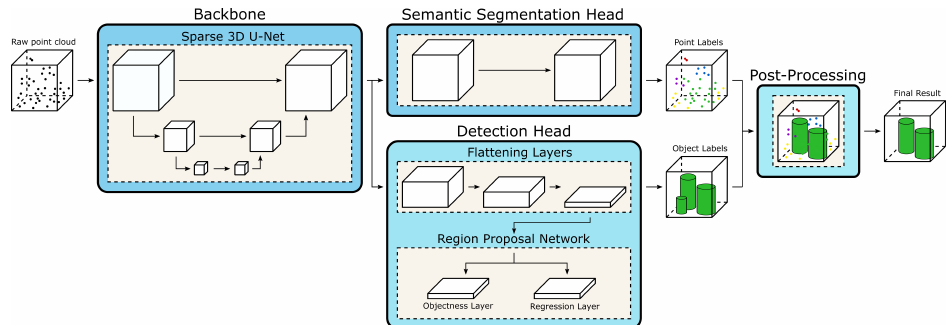
Figure 1. Overall pipeline including the network architecture scheme. Note that we used two independently trained instances of the backbone; see Section 3.1.2 for